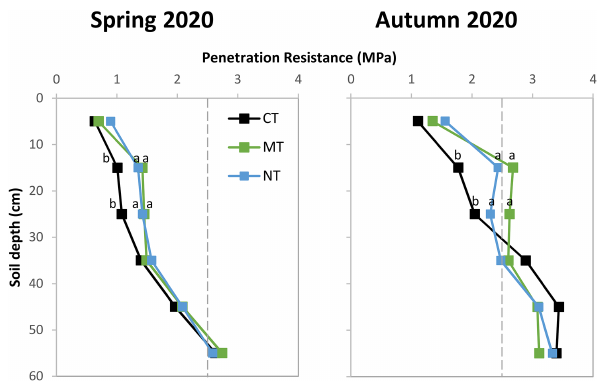
Figure 3. Penetration resistance (PR) along the 0–60cm soil profile (values averaged every 10cm). Different letters represent significant differences according to the post hoc Tukey test ( p < 0 . 05). The vertical dashed line indicates the 2.5MPa threshold, according to Groenevelt et al. (2001). Note: CT – conventional tillage; MT – minimum tillage; NT – no tillage.